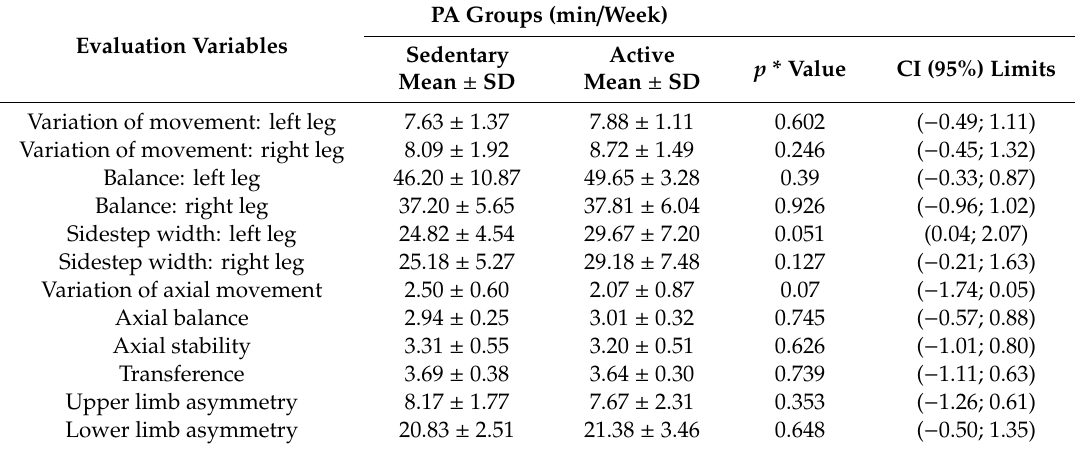
Table 7. Lower limbs. Di ff erences between sedentary and active